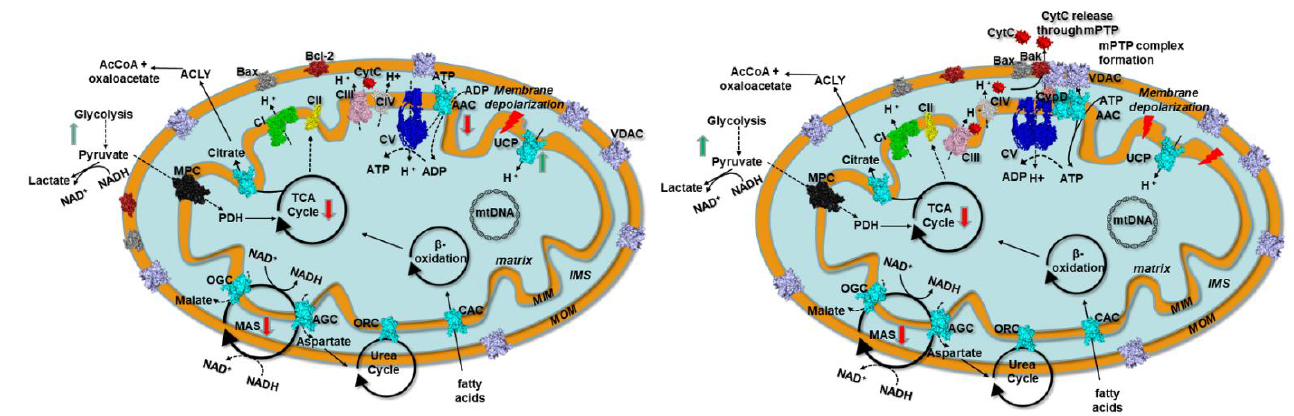
Figure 6. Scheme of mitochondria with a set of representative proteins, pathways, and cycles in kidney cancer prior and after mPTP formation. Left panel. Kidney cancer mitochondria resistant to mitochondrial apoptosis. Right panel. Kidney cancer mitochondria after mPTP formation. Respiratory chain complexes, mitochondrial transporters, and other proteins are reported in surf representation and labeled. ATP synthase (CV) is reported in blue. Mitochondrial carriers are reported in cyan. VDAC is reported in pink. Bax and Bak/Bcl-2 are reported in dark-grey and firebrick, respectively. MPC is reported in black. Complex I (CI), complex II (CII), complex III (CIII), and complex IV (CIV) are reported in green, yellow, magenta, and grey, respectively. Black circular arrows indicate cyclic pathways. Red arrows indicate impaired pathways or reactions. Green arrows indicate upregulated pathways or reactions. Black dashed lines indicate impaired reactions. Abbreviations: MIM: mitochondrial inner membrane; MOM, mitochondrial outer membrane; IMS, intermembrane space; AAC, ADP/ATP carrier; CAC, carnitine/acyl-carnitine carrier; ORC, ornithine carrier; AGC, aspartate/glutamate carrier; OGC, malate/2-oxoglutarate carrier; MAS, malate/aspartate shuttle; TCA, tricarboxylic acid cycle; Bax, Bcl-2 associated X protein;Bak, Bcl-2 antagonist/killer-1; Bcl-2, B-cell lymphoma-2; MPC, mitochondrial pyruvate carrier; UCP, uncoupling protein; CypD, cyclophilin D; CytC, cytochrome C; VDAC, voltage-dependent anion channel; AIF, apoptosis-inducing factor; mPTP, mitochondrial permeability transition pore.